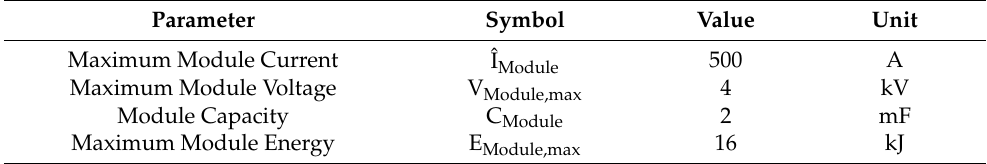
Table A1. Ratings of individual PEBC module.